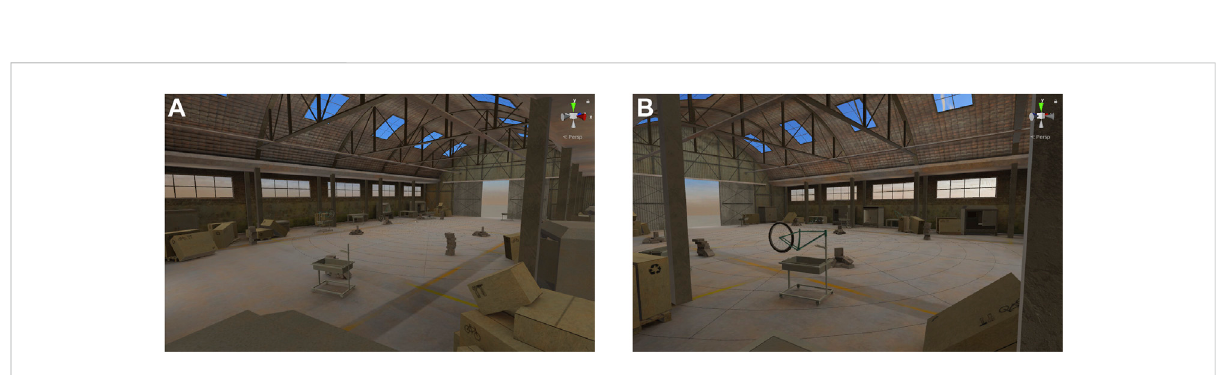
FIGURE 3 Views of the virtual warehouse the participants are placed in.